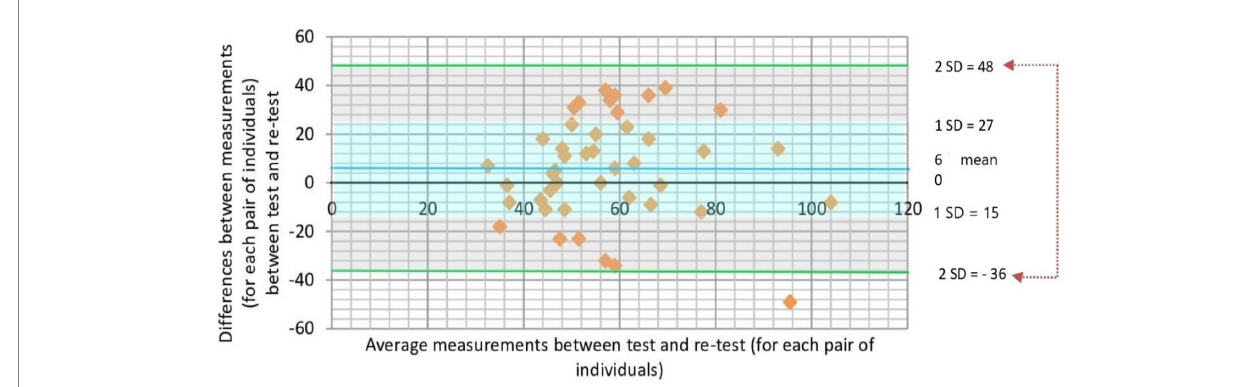
FIGURE 6 Scatter plot showing the magnitude of difference and size of measurement for the VRT variable measured in the first and second tests using the same subject. The difference between the paired measurements is plotted on the vertical-axis and average of the measures of first and second tests on the horizontal-axis. The mean difference in values obtained with test and retest (bias) is represented by a central horizontal line on the plot. Horizontal lines above and below the central horizontal line represent the 95% limits of agreement (LOA—upper and lower LOA). A priori defined clinical criteria considered clinically relevant differences those that are greater than 20 ms. Note that all values are between ±2SD from the mean, and more than 70% of values are within ±1SD from the mean. VRT, variability of reaction time.